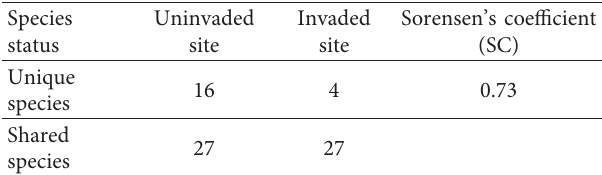
Table 8: Sorenson’s index of native species in study sites.